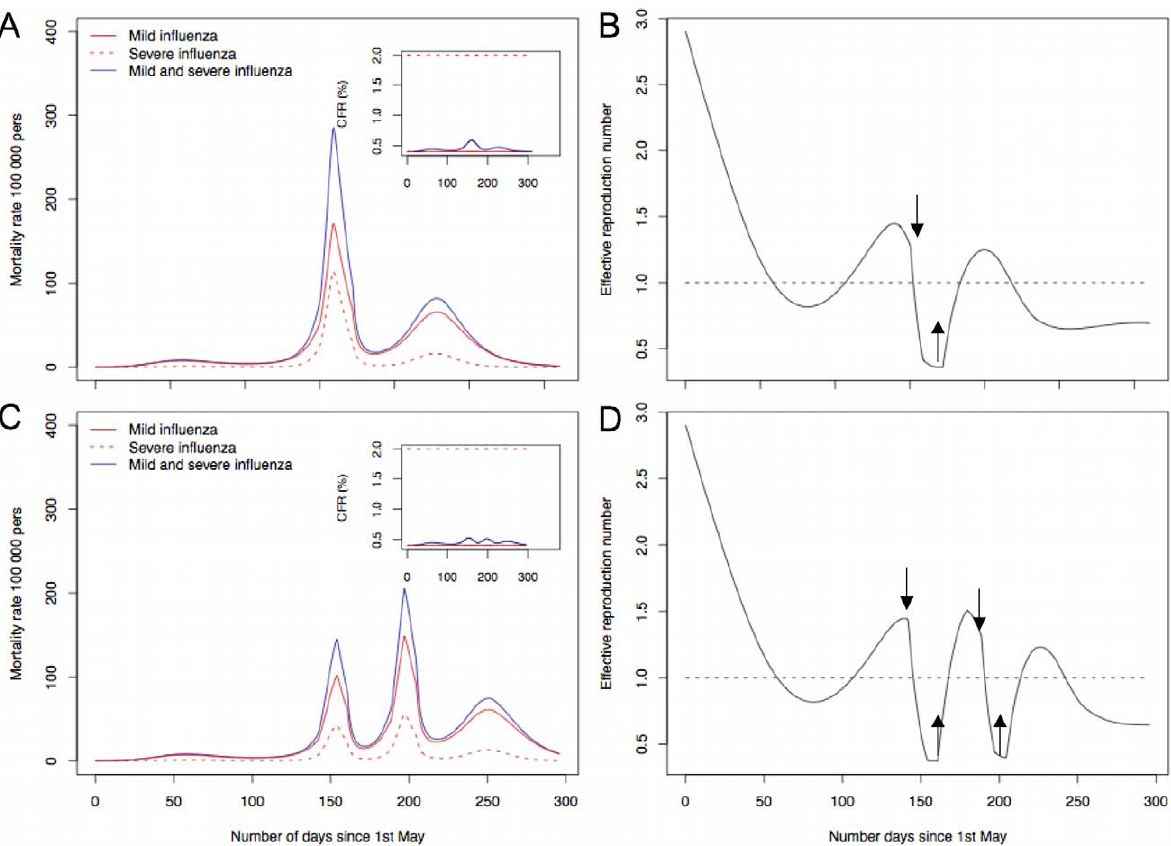
Figure 3. Dynamics of influenza pandemic with volunteer isolation. A and B volunteer isolation started when the number of deaths was above 400 and persons returned to community when the number of deaths was bellow 100 and C and D volunteer isolation started when the number of deaths was above 200 and persons returned to community when the number of deaths was bellow 100. Arrows in B and D indicate the time at which persons leave and return to the susceptible compartment.